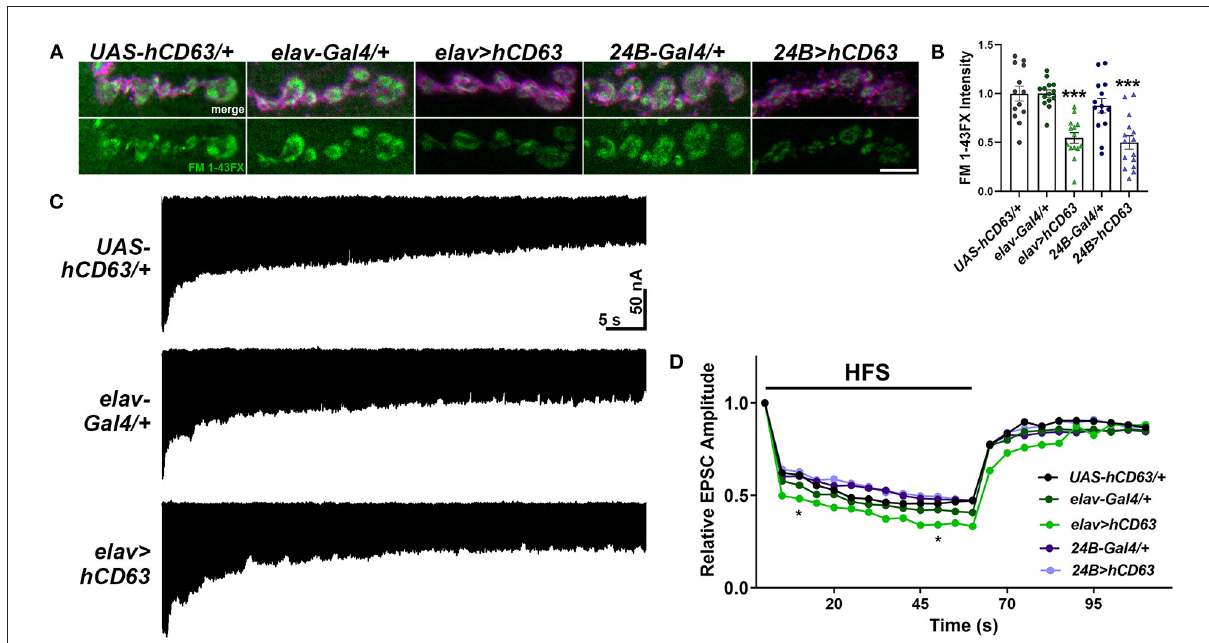
FIGURE7 Expression of human CD63 in Drosophila larval neurons impairs endocytosis. (A) Representative confocal images showing relative rates of endocytosis in HL-3 + 1.0mM Ca 2 + as measured by FM 1-43FX immunofluorescence in 6/7 terminal boutons of genotypes as indicated. (B) Quantification of FM 1-43FX fluorescence intensity relative to the UAS-hCD63/ + outcrossed controls. FM 1-43FX fluorescence is significantly reduced when hCD63 is expressed in neurons ( elav > hCD63 ; F (2,38) = 21.18, p < 0.0001, one-way ANOVA) and in muscle ( 24B > hCD63 ; F (2,39) = 12.97, p < 0.0001, one-way ANOVA). (C) Representative recordings from animals during 20Hz stimulation in HL-3 + 1.0mM Ca 2 + . (D) Relative EPSC amplitudes over time during both 20Hz stimulation (first 60s) and the recovery period (final 50s). Expressing human CD63 (hCD63) in neurons using the elav-Gal4 driver resulted in a significant decrease in EPSC amplitudes at 10 and 50s as determined by a two-way ANOVA ( F (53,1166) = 25.37, p < 0.0001) followed by post hoc Dunnett’s multiple comparisons